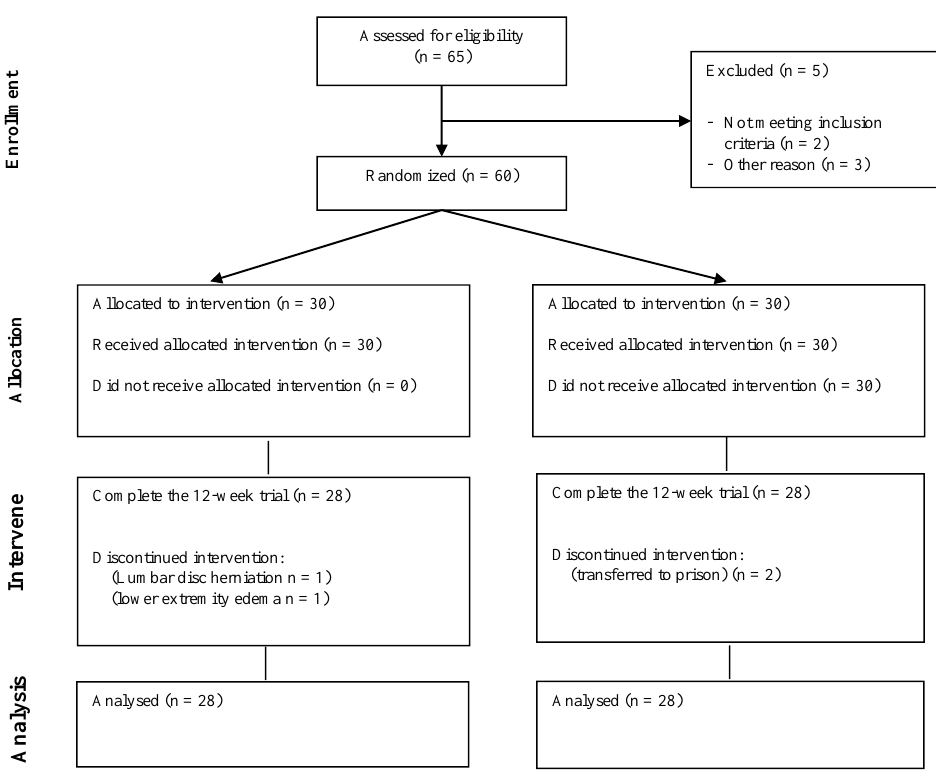
Figure 1. Flow chart of subject Figure 1 . Flow chart of subject recruitment.